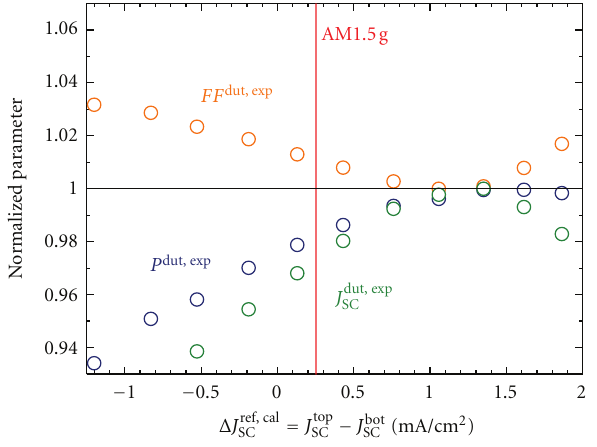
F 9: e transformation calculated for the calibrated reference is applied to shi the normalized power , �ll factor FF, and short of the test cell under experimental test circuit current density SC illumination (dut, exp) to the calibration illumination conditions. 𝑃𝑃𝑃𝑃 Forthistestcellpowermatchingandcurrentmatchingcoincide.e 𝐽𝐽𝐽𝐽 device is top limited under AM1.5g illumination.